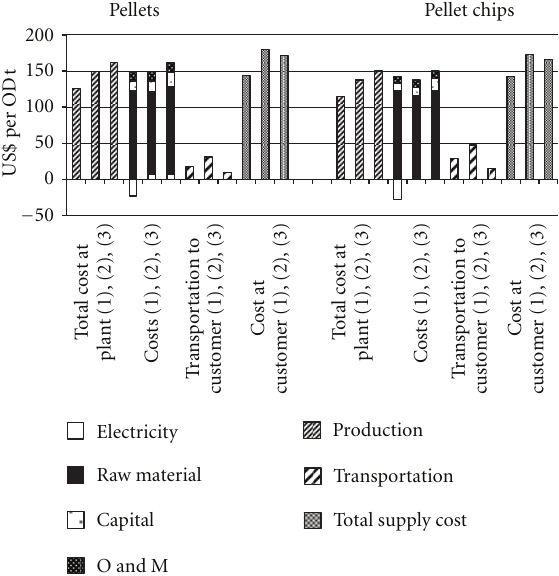
Figure 2: Supply costs for pellets (left) and pellet chips (right) when produced at (1) Lycksele, (2) Vilhelmina, and (3) V¨ann¨as. Each plant was assumed to have a capacity of 15000 oven-dry tonnes (ODt), with logging residues used as the raw